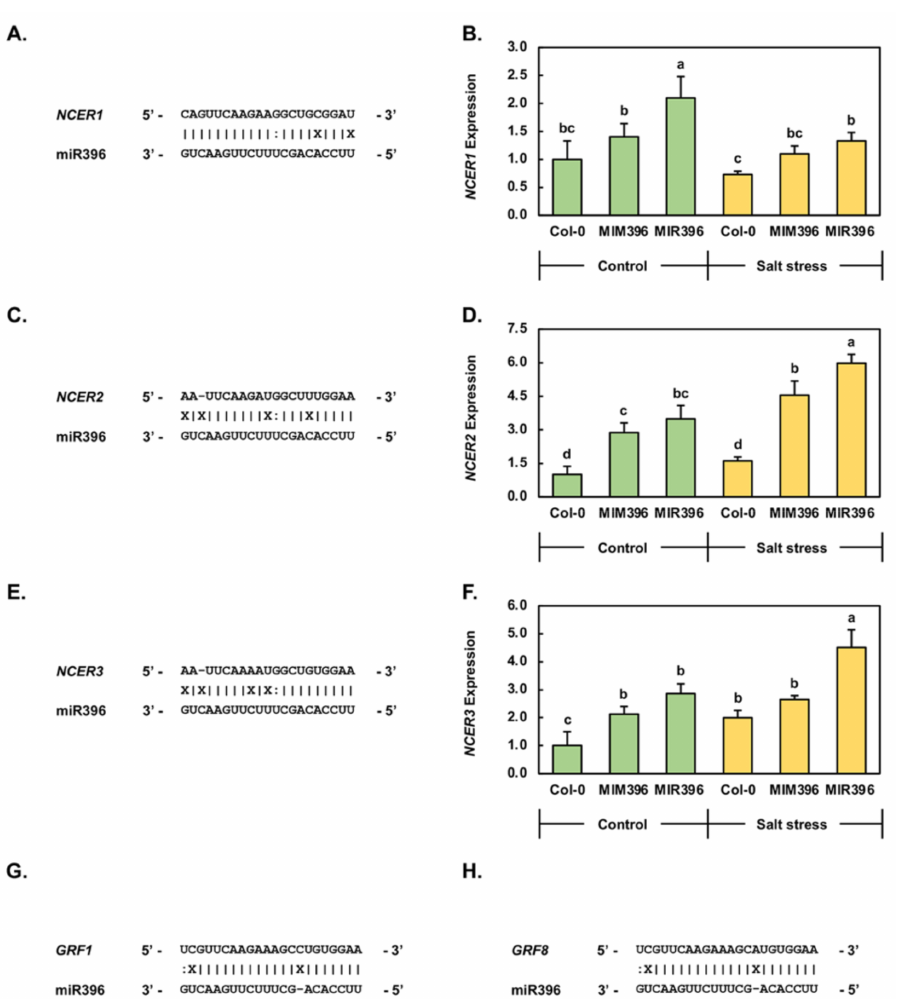
Figure 4. RT-qPCR assessment of NCER1 , NCER2 , and NCER3 expression in control and salt-stressed Col-0, MIM396 , and MIR396 plants. Base pair predictions that putatively form between the miR396a sRNA and the NCER1 ( A ), NCER2 ( C ), and NCER3 ( E ) transcripts. RT-qPCR analysis of NCER1 ( B ), NCER2 ( D ), and NCER3 ( F ) gene expression in Col-0/Ns, MIM396 /Ns, MIR396 /Ns, Col-0/NaCl, MIM396 /NaCl, and MIR396 /NaCl plants. Base pairing which forms between miR396 and its two well-characterized target genes ( G ) GRF1 and ( H ) GRF8 . ( B , D , F ) Error bars represent the standard deviation of four biological replicates. The statistical data were analyzed using the one-way ANOVA and Tukey’s post hoc tests, and a statistically significant difference is represented by a different letter ( p < 0.05) above each histogram